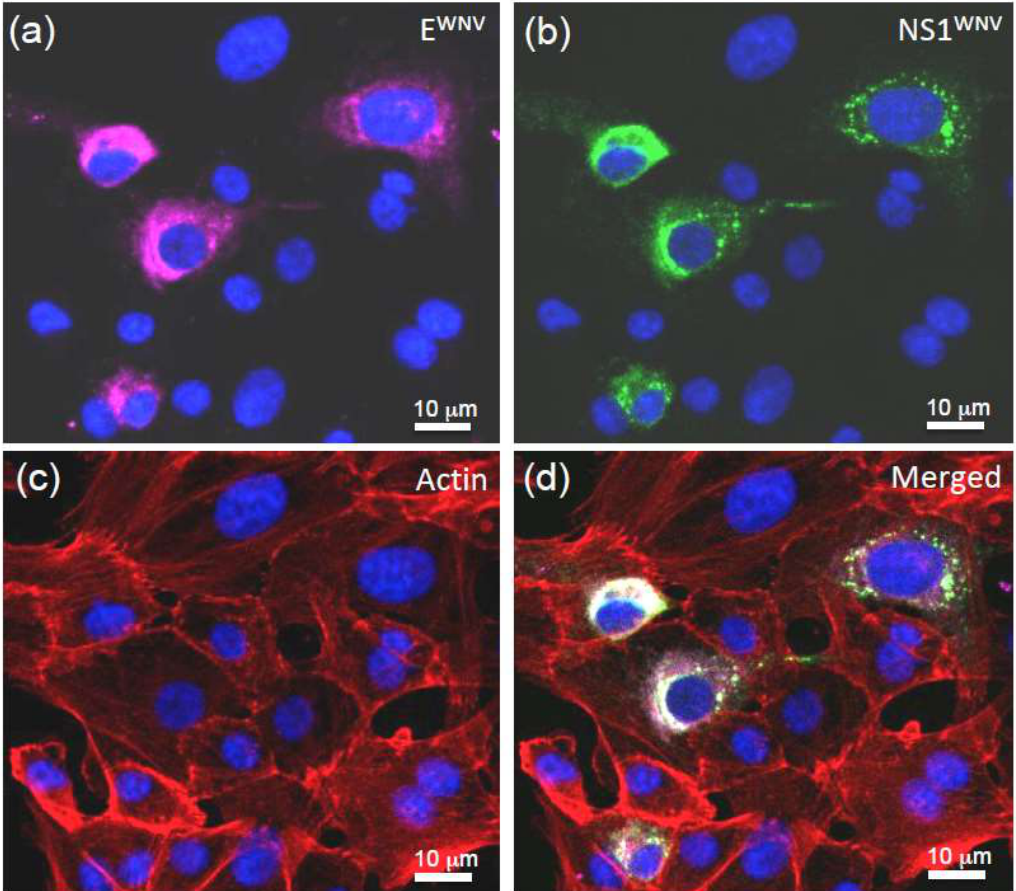
Figure 8. TNT-like structures in WNV-infected cells. Vero E6 cells were infected with WNV at MOI 0.5, and harvested at 18 h post-infection. After fixation and permeabilization, the cells were reacted with rhodamine–phalloidin to visualize the actin network, with an antibody against NS1 WNV , and with anti-glycoprotein-E WNV antibody to localize the virus and identify the WNV-infected cells. ( a ) E WNV envelope glycoprotein (purple); ( b ) NS1 WNV protein (green); ( c ) actin (red); ( d ) merged signals. Nuclei were stained in blue using DAPI reagent. Note that the thin filament connecting a WNV-infected cell to a non-infected cell contained both NS1 WNV and E WNV .